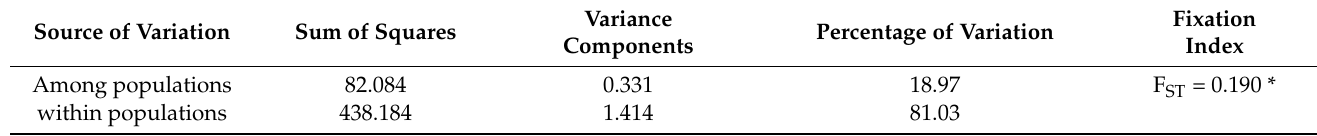
Table 3. Analysis of molecular variance (AMOVA) of four snail populations.